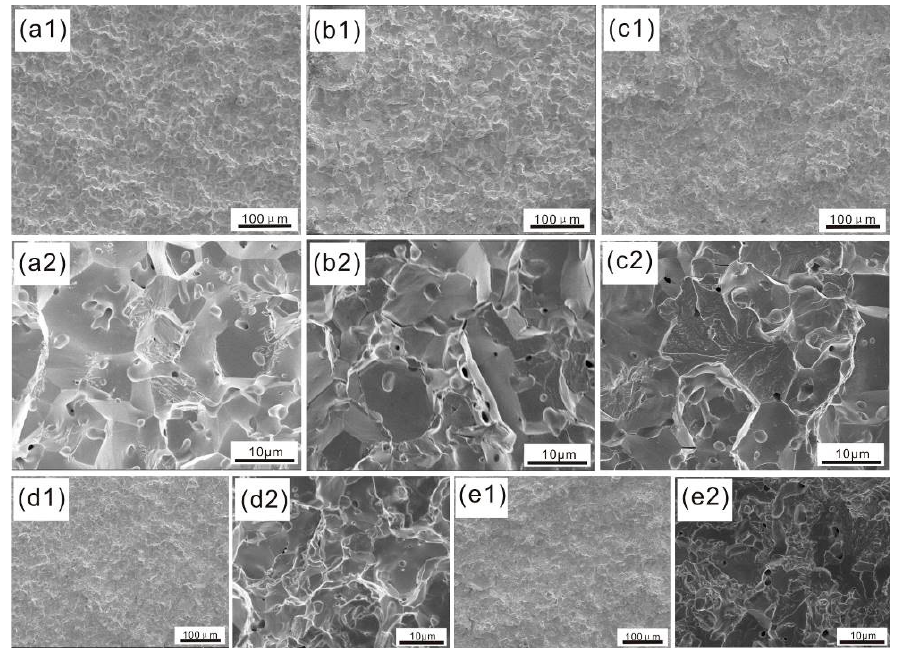
Figure 7. Tensile fracture section morphology of Ta-W alloy with different W contents ( a1 , a2 ) Pure Ta, ( b1 , b2 ) Ta-2.5 wt%W, ( c1 , c2 ) Ta-5 wt%W, ( d1 , d2 ) Ta-7.5 wt%W, ( e1 , e2 ) Ta-10 wt%W.